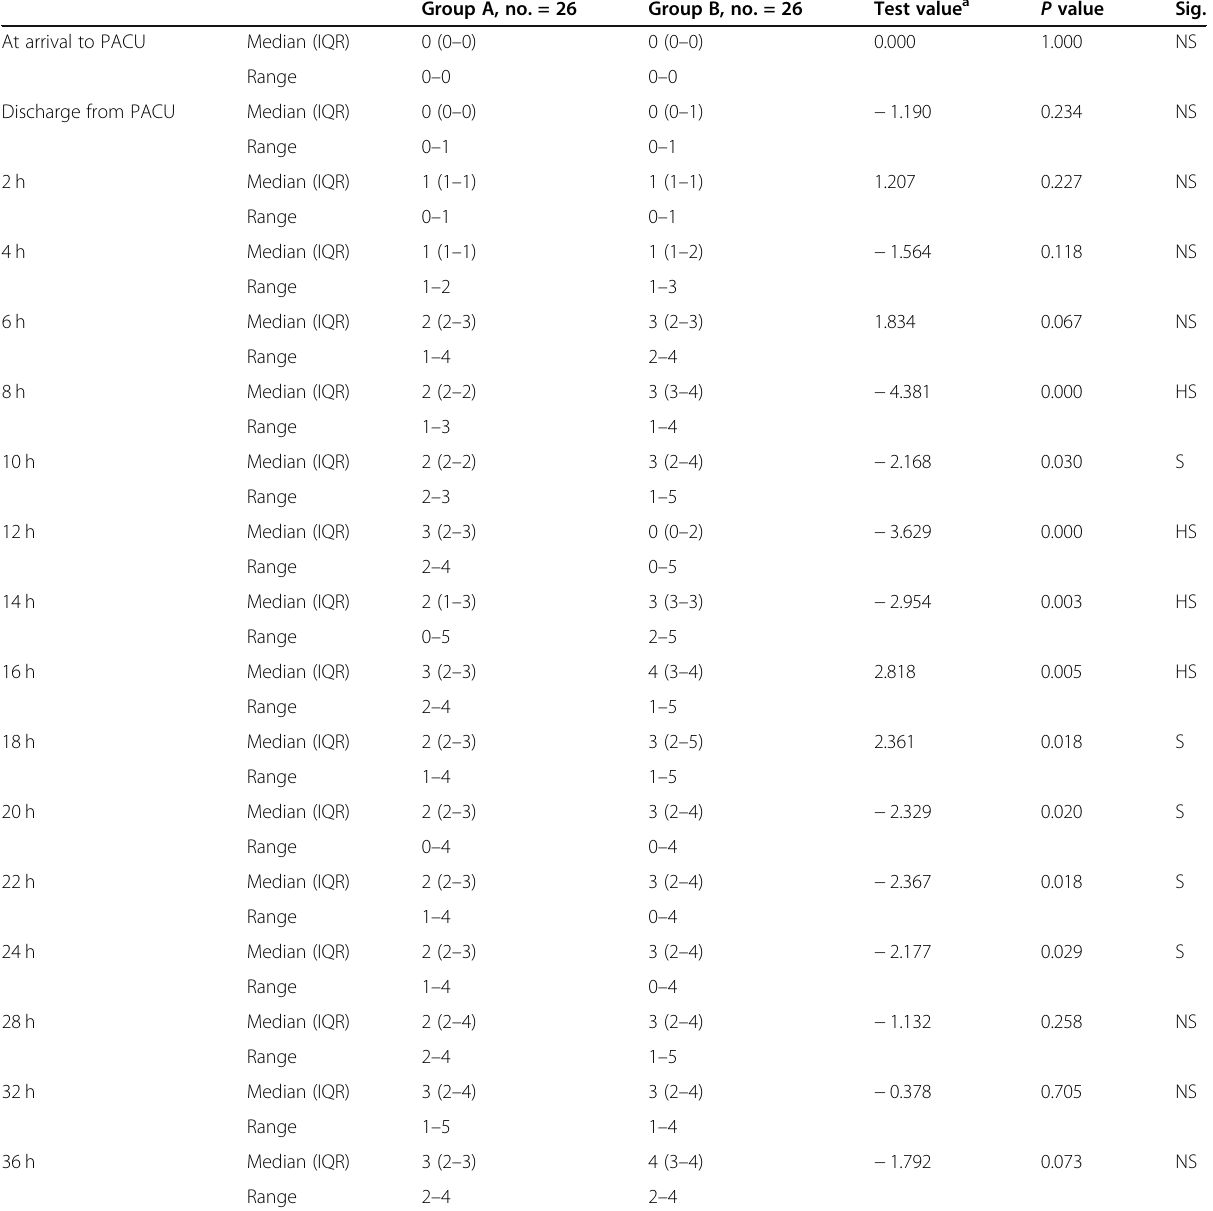
Table 4 Comparison between group A and group B regarding FLACC score at different times of measurement Group A, no. = 26 Group B, no. = 26 Test value a